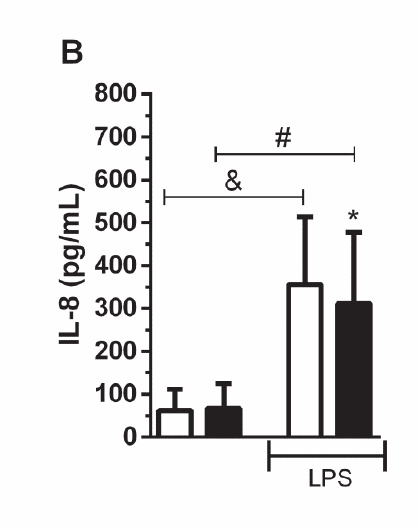
FIGURE 5 – DHEA reduces the IL-8 production by neutrophils infected with S. Typhimurium or stimulated with LPS. Cells (2 x 105) were treated with 0.01 µM DHEA for 1 hour and infected with S. Typhimurium (MOI=10) for 24 h in the presence of 49.5 µM of a bacteriostatic concentration of cloramphenicol or, were stimulated with 1 µg/mL of LPS for 18 hours The IL-8 were quantified in the supernatant using ELISA for IL-8. Data express the Mean (SD) of 3 independent experiments with cells from 6 different donors.